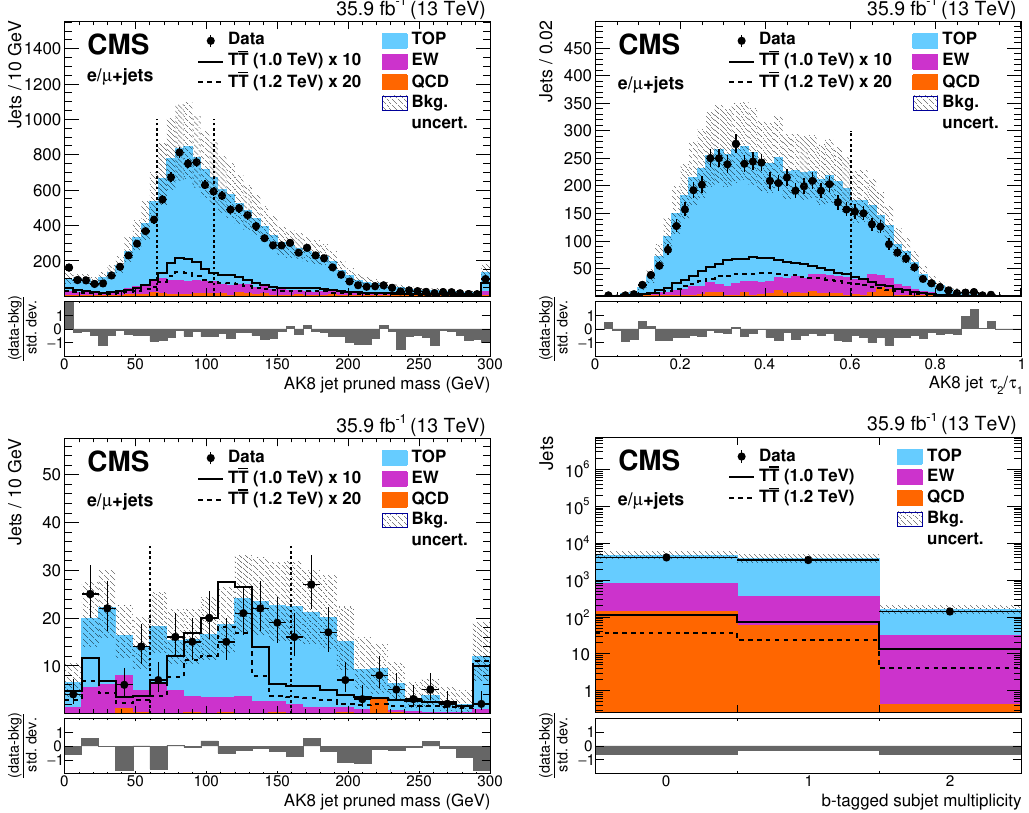
Figure 2 . Distributions of W and H tagging input variables after all selection requirements, before the (cid:12)t to data: pruned mass in AK8 jets with (cid:28) 2 =(cid:28) 1 < 0 : 6 (upper left), N -subjettiness (cid:28) 2 =(cid:28) 1 ratio in AK8 jets with pruned mass between 65{105 GeV (upper right), pruned mass in AK8 jets with two b-tagged subjets (lower left), and number of b-tagged subjets in AK8 jets with pruned mass in the range 60{160 GeV (lower right). Vertical dashed lines mark the selection windows for each distribution. The black points are the data and the (cid:12)lled histograms show the simulated background distributions, grouped into categories as described in section 3. The expected signal is shown by solid and dotted lines for T quark masses of 1.0 and 1.2 TeV. The (cid:12)nal bin includes over(cid:13)ow events. Uncertainties, indicated by the hatched area, include both statistical and systematic components. The lower panel shows the di(cid:11)erence between data and background divided by the total uncertainty. function that describes the observed di(cid:11)erence in the H T spectrum between binned and inclusive simulations [28, 69,